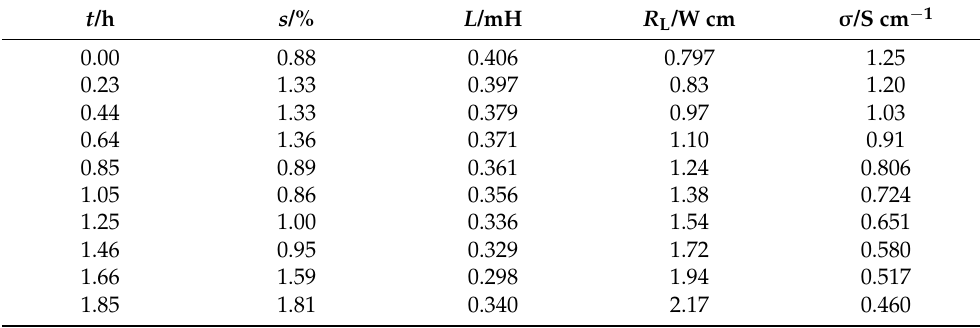
Table 7. Results of fitting the impedance spectra recorded for Ni–5CBCY during oxidation in wet air before the loss of metallic conductivity ( t —time elapsed from the beginning of the experiment; s —standard deviation; fitted parameters (for the EEC presented in Figure 14a): L —inductance; R L —resistance; σ —electrical